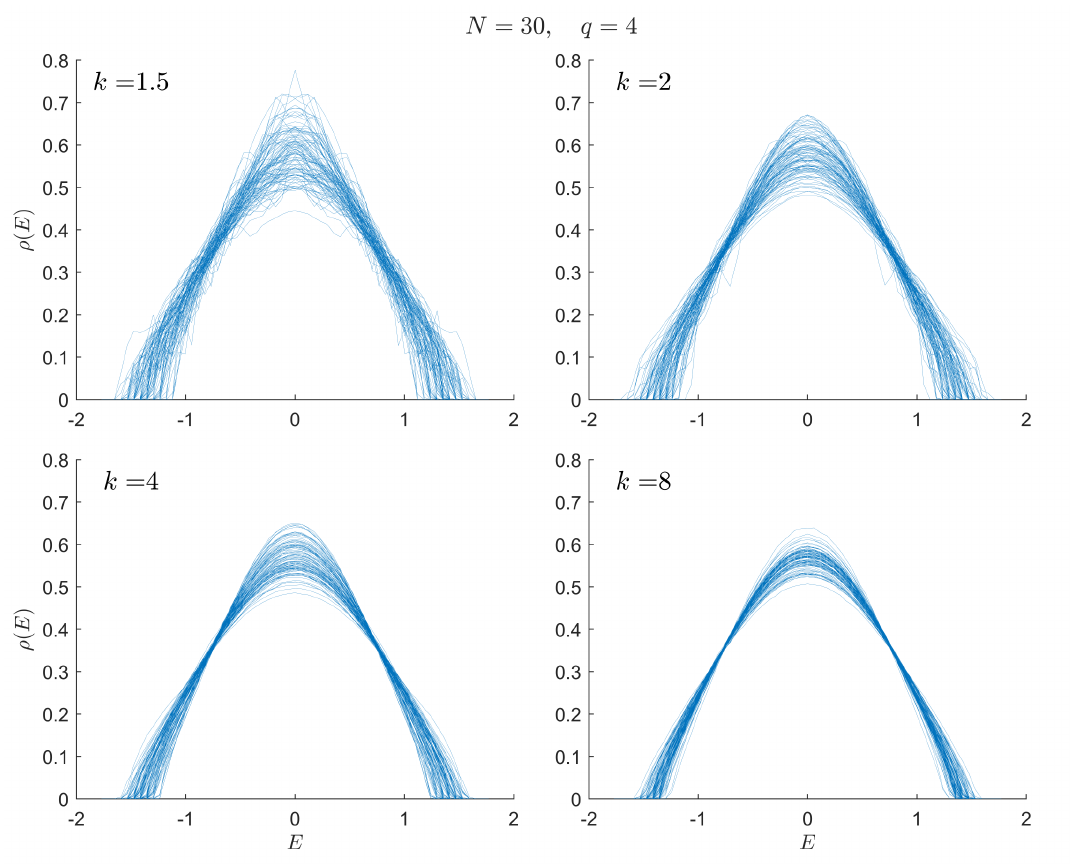
Figure 10 . The spread of the spectral density of the sparse SYK Hamiltonian for 100 disorder realizations and for various values of k